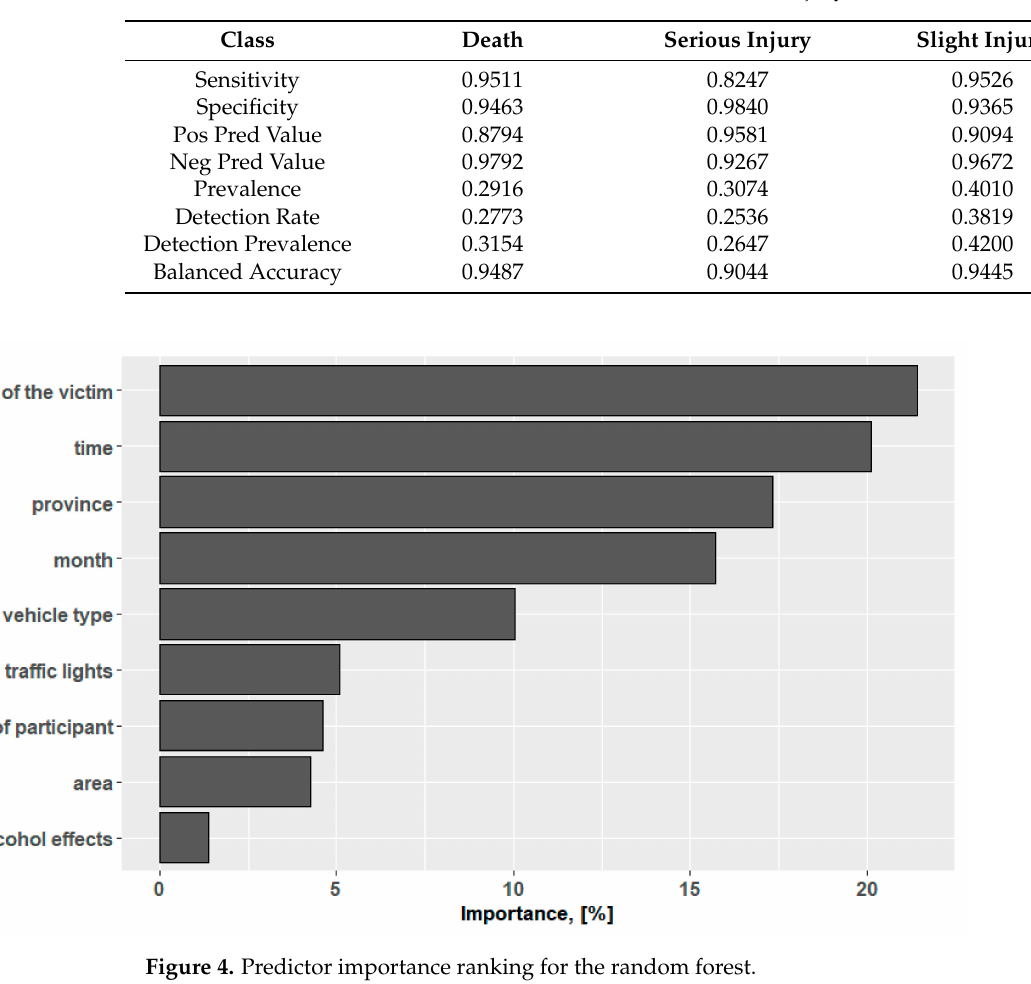
Table 6. Detailed measures of the random forest for the individual injury classes.